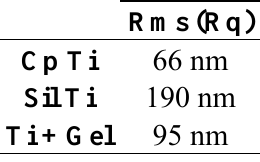
Table 3. Surface roughness values (Rms) of commercially pure Ti (cp Ti), TMSPMA silanized Ti (Sil Ti) and gelatin-coated Ti obtained using AFM